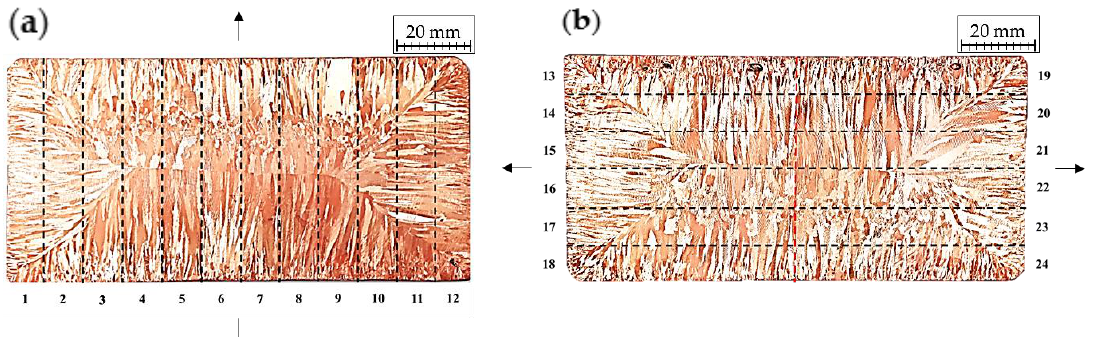
Figure 2. Schematics of division of copper strand into samples designated for uniaxial tensile test, where ( a ) the tensile force is parallel to the height of the strand, ( b ) the tensile force is perpendicular to the height of the strand.